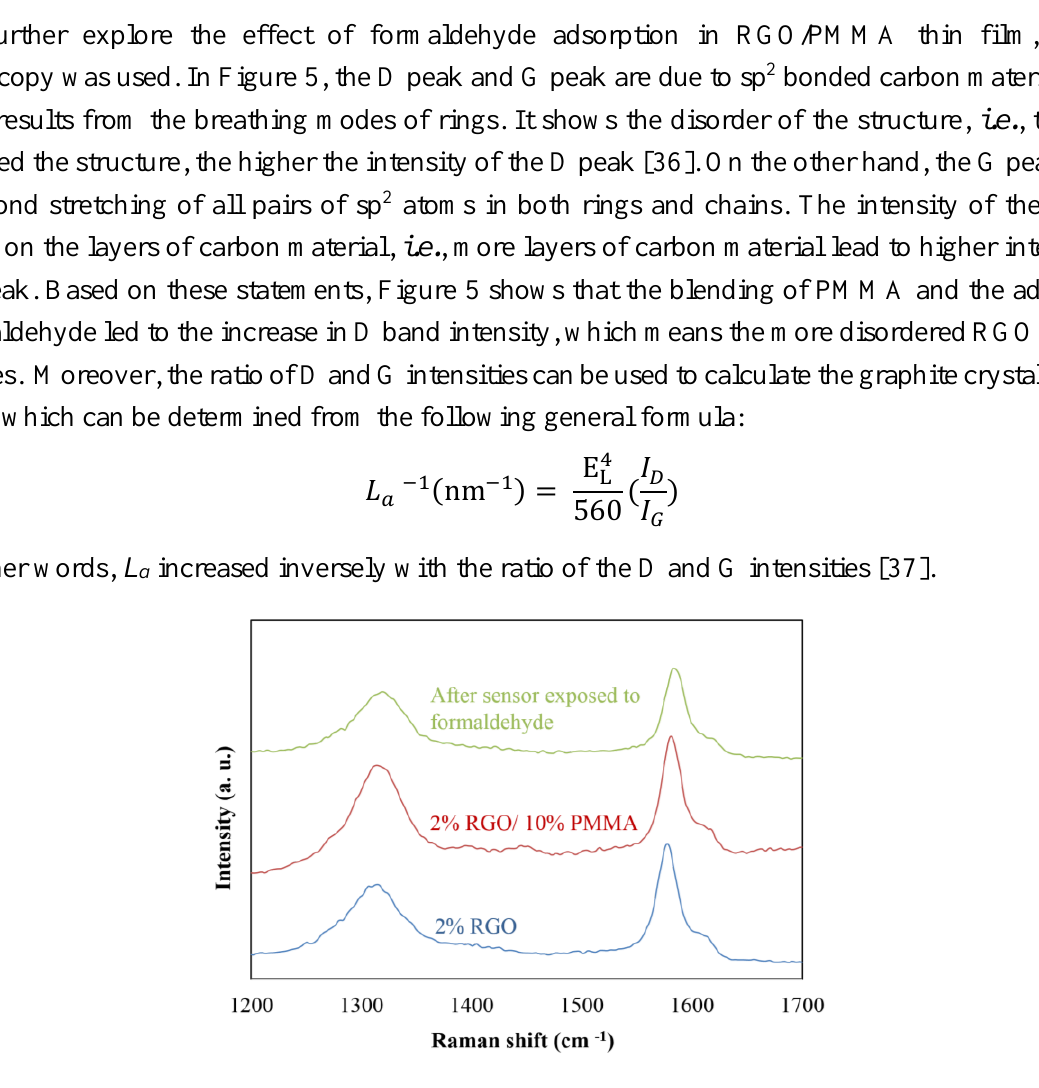
Figure 5. Raman spectroscopy (E L = 1.59 eV and λ L = 780 nm) of the RGO-based sensing